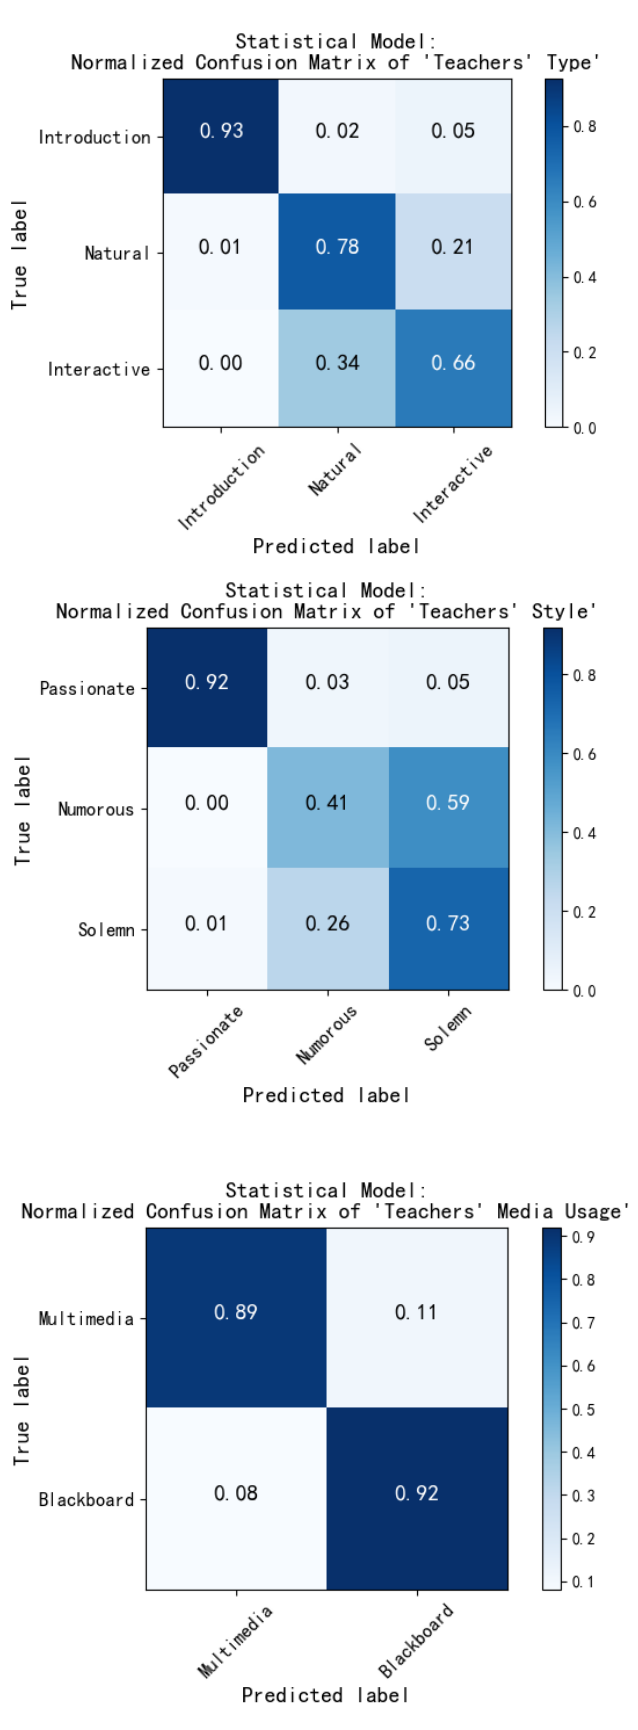
Figure 10. Confusion matrix for category indicators evaluated by the statistical modeling module. According to the confusion matrix, it is easy to calculate the performance parameters of each category of three indicators: The precision, recall, F1-score value of each class, and accuracy, M_P, M_R, M_F1 to evaluate the global performance of statistical modeling, as shown in Table 8. According to the above table, among the various categories’ evaluation of teachers’ type, “indoctrination” performs well, and the rest is mediocre, and the overall perfor- mance of the method is in the evaluation of teachers’ style, the performance of “passion- ate” is better than that of “humorous” and “solemn”. The overall performance of the model for this indicator is relative. There are only two categories in the teachers’ media usage, and the overall performance is also good.